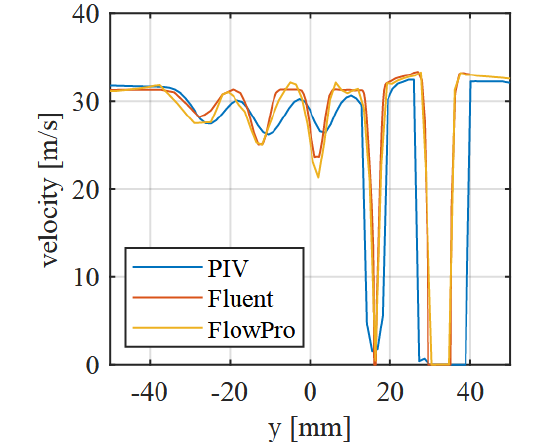
Fig. 2. Velocity profile comparison 100 mm behind for